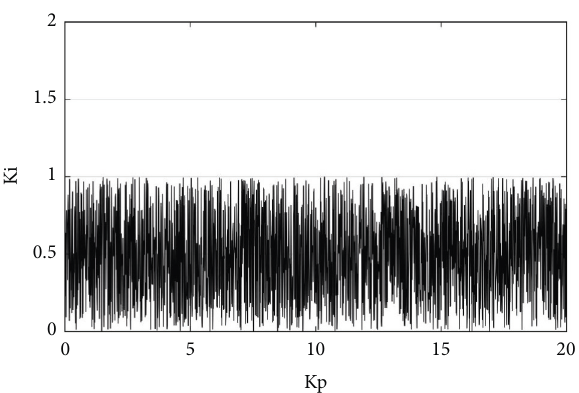
Figure 2: K I variation